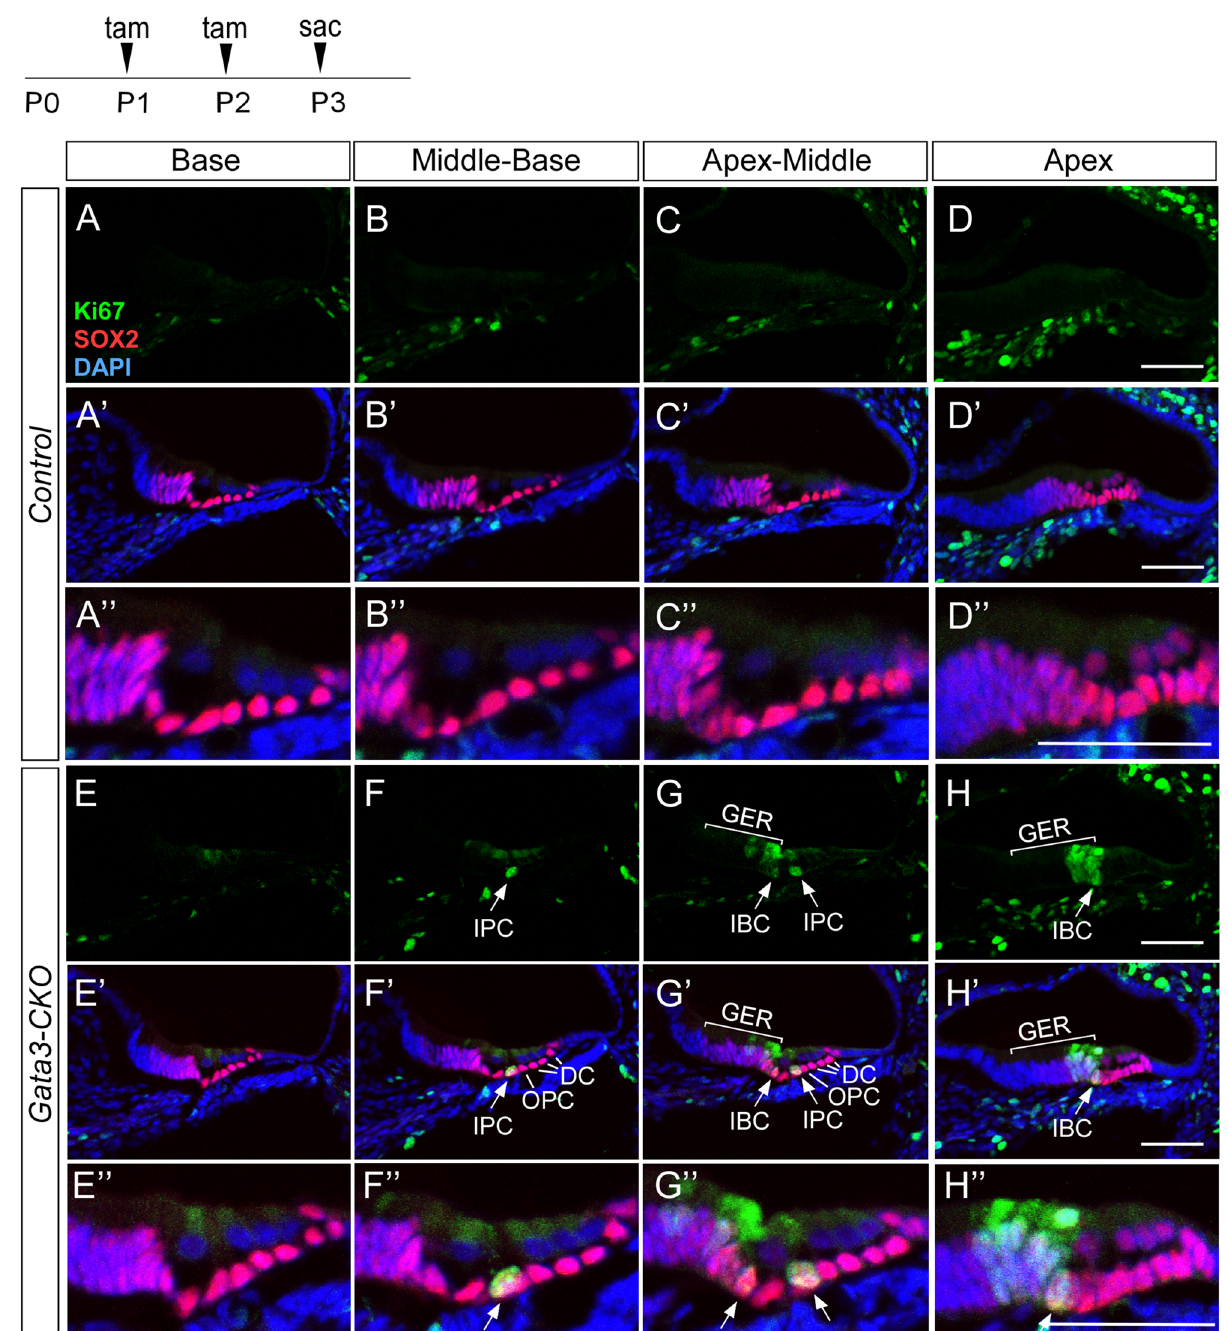
Figure 4. Deletion of Gata3 results in the proliferation of IPCs, IBCs, and cells in the lateral GER. ( A – D , A ′ – D ′ , A ″ – D ″ ) Immunolabeling of Ki67 (green), a marker of cell proliferation, shows that SCs and GER have exited the cell cycle in control cochleae. ( E – H , E ′ – H ′ , E ″ – H ″ ) In Gata3- CKO cochleae, the expression of Ki67 is detected in IPCs, IBCs, and lateral GER. Scale bar 50